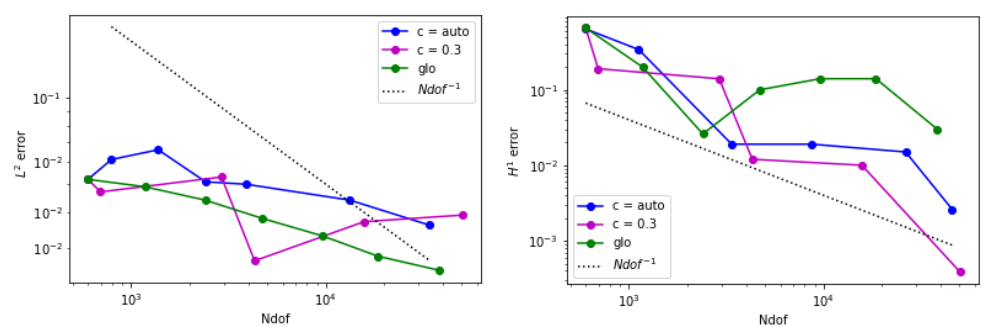
Figure 24. Error behavior for example 4 when η R is adopted. ( Left ) The estimated L 2 norm of the error is displayed. ( Right ) The estimated H 1 seminorm is shown.